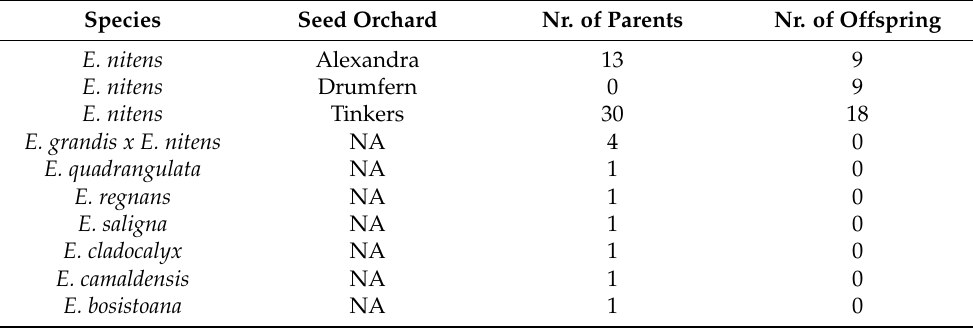
Table 1. Structure of the studied population. Species Seed Orchard Nr. of Parents Nr. of Offspring E. nitens Alexandra 13 9 E. nitens Drumfern 0 9 E. nitens Tinkers 30 18 E. grandis x E. nitens NA 4 0 E. quadrangulata NA 1 0 E. regnans NA 0 E. saligna NA 1 0 E. cladocalyx NA 1 0 E. camaldensis NA 1 0 E. bosistoana NA 1